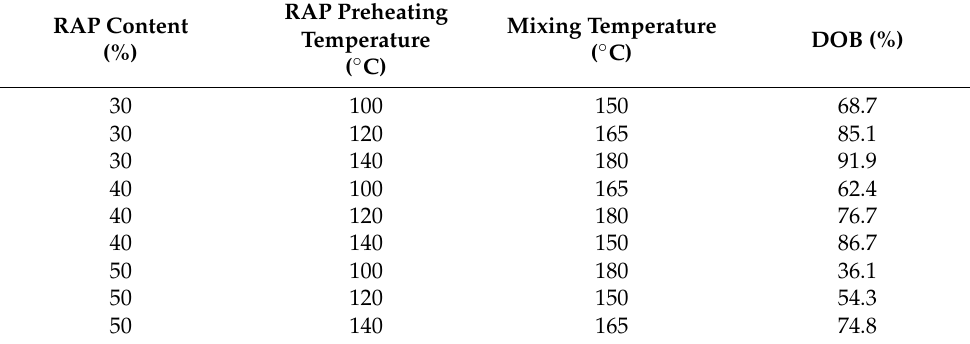
Table 5. DOB test results.